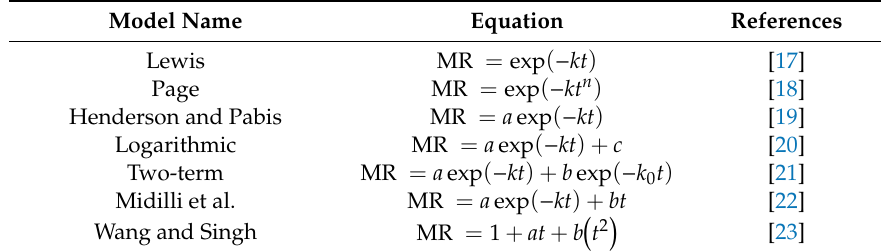
Table 1. Drying models used for describing the drying characteristics of radish slabs. MR: moisture ratio. Model